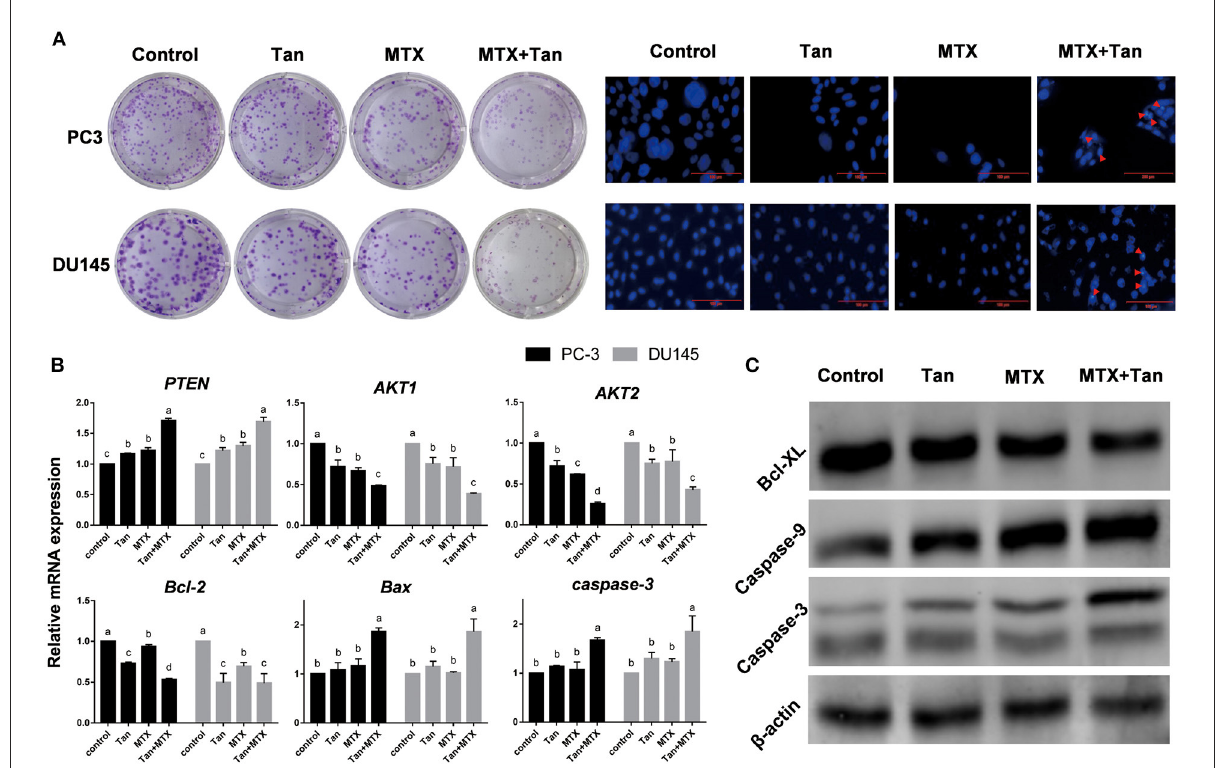
FIGURE6 Morphology and gene and protein expression regulated by tangeretin (Tan), mitoxantrone (MTX), or their combination (MTX + Tan) in prostate cancer cell lines. (A) Images of clonogenic assay- and DAP-stained cells. The red arrowheads indicate apoptotic bodies. (B) Relative gene expression detected by qRT-PCR. (C) Protein expression detected by western blot